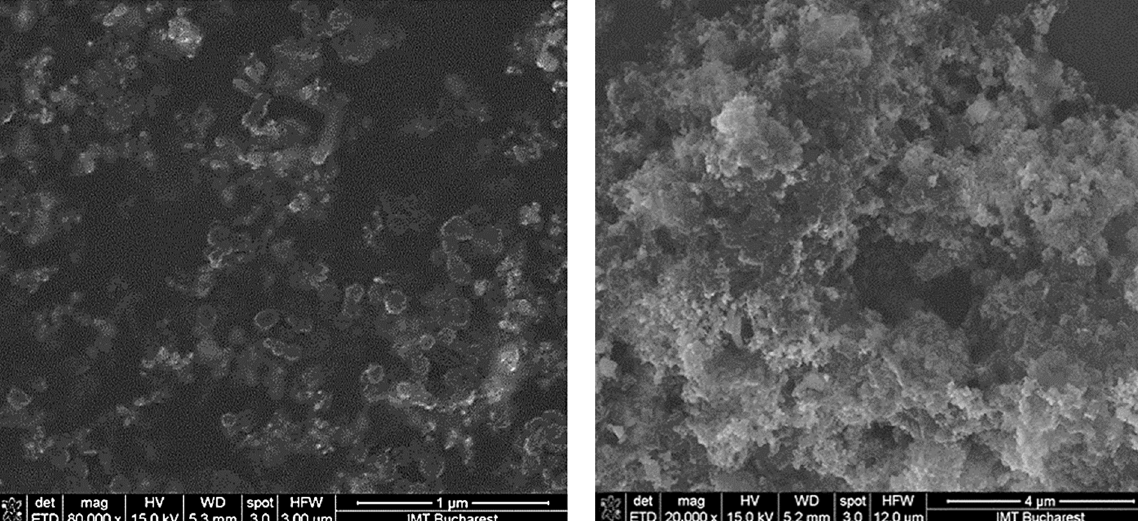
Figure 2. Scanning electron micrographs of the CNHox/SnO 2 /ZnO/PVP = 1.5/1/1/1, w/w/w/w ratio.